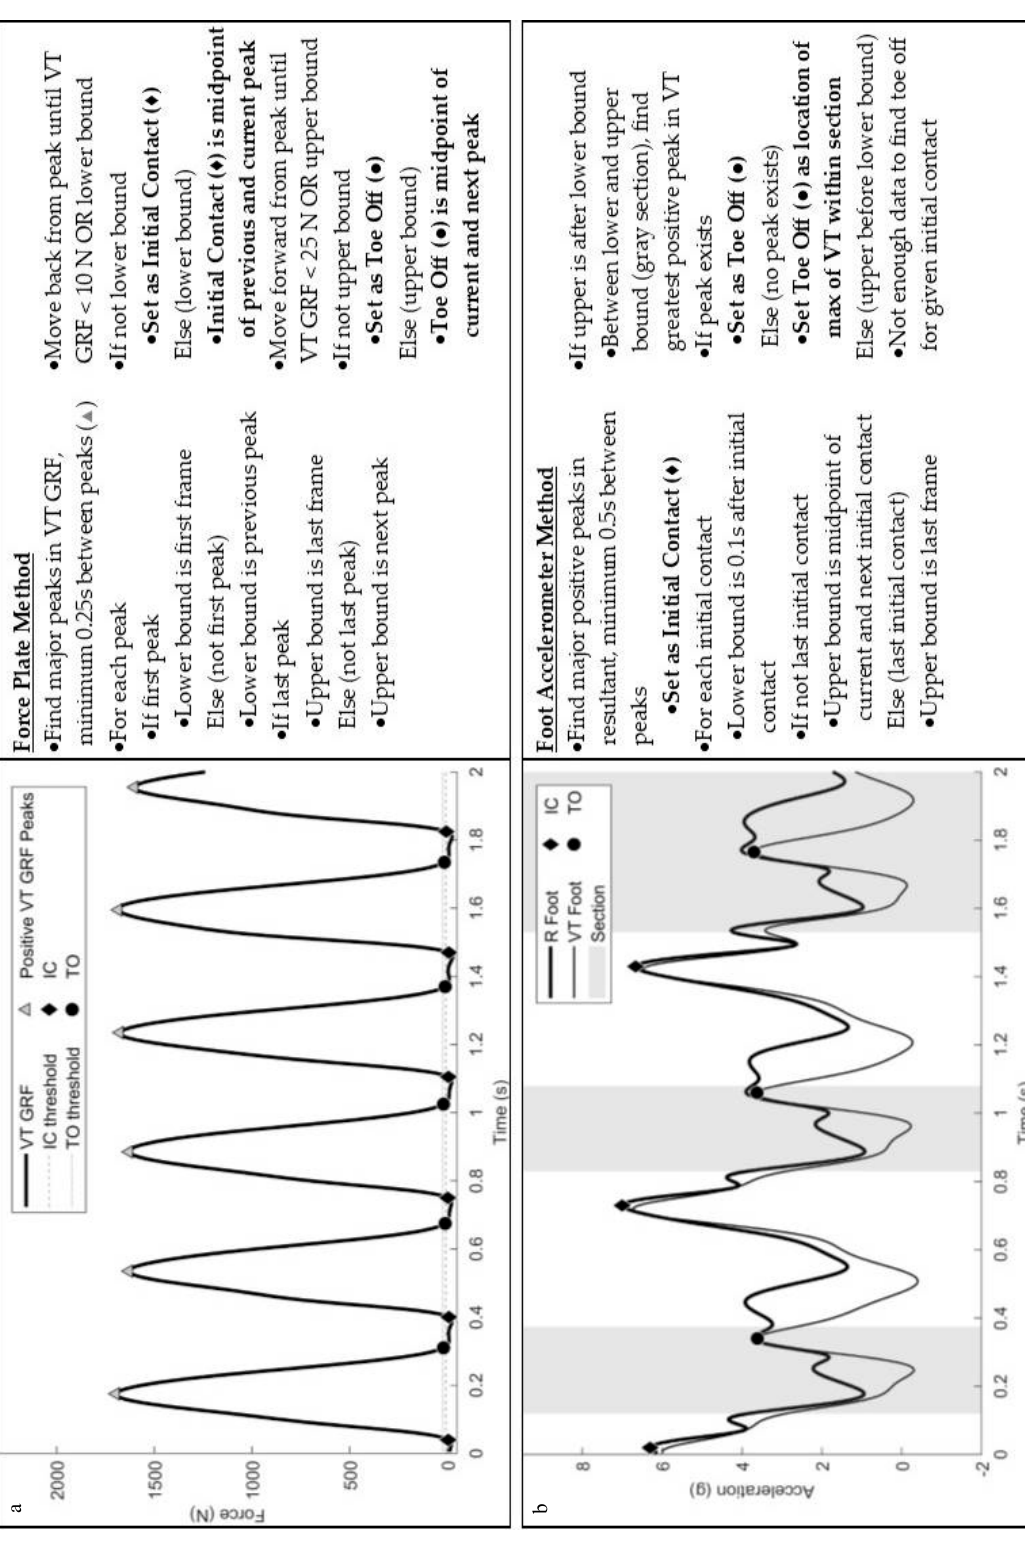
Figure 1. Illustration and description of the ( a ) force plate and ( b ) foot accelerometer gait event detection methods.